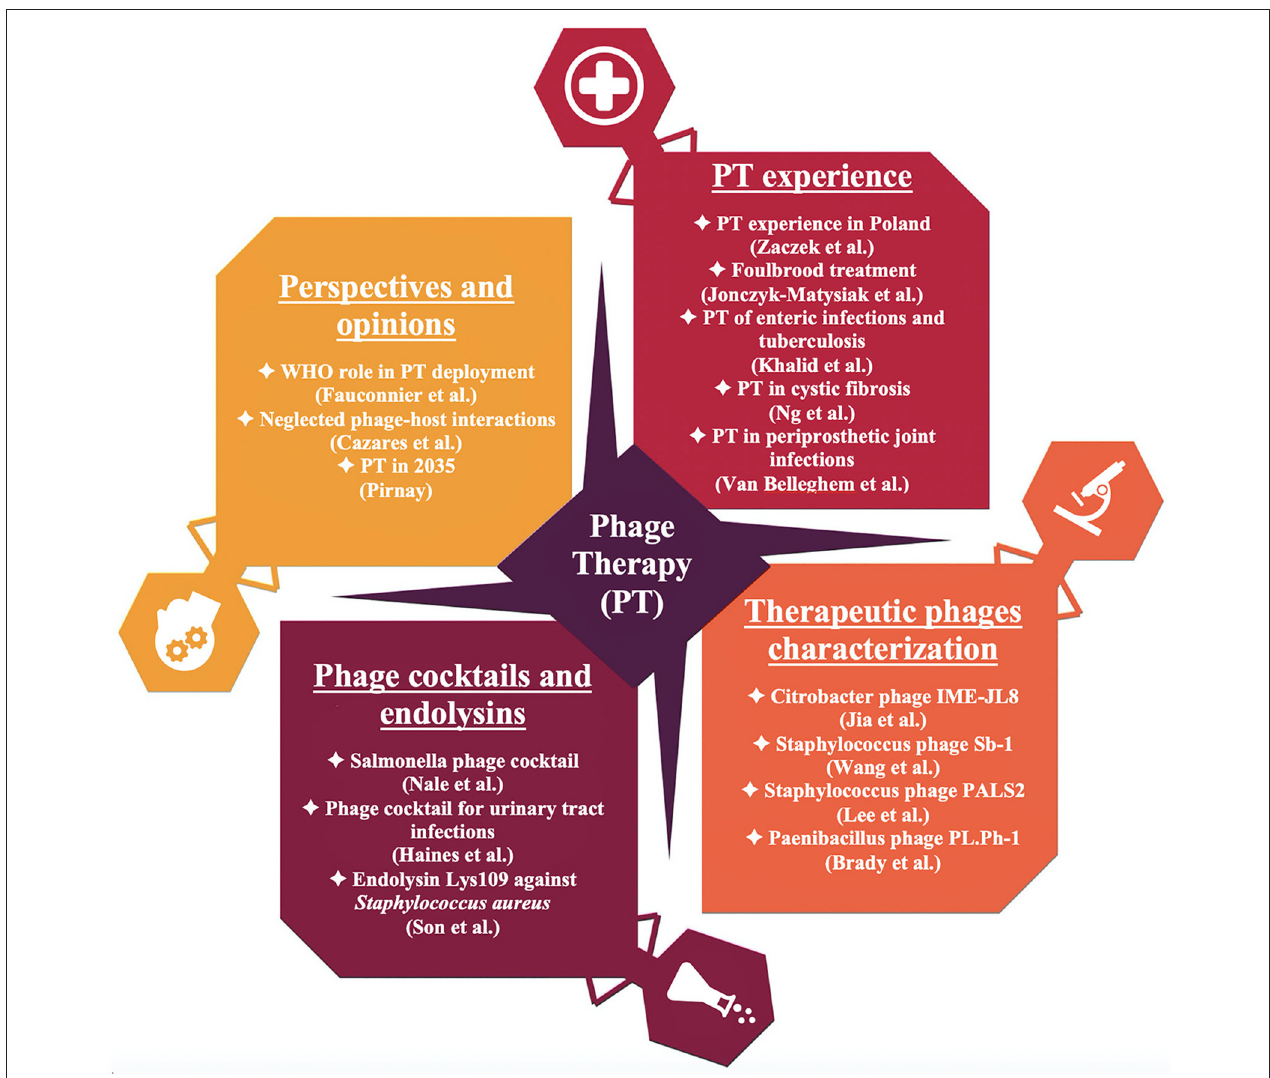
FIGURE 1 | Contribution of the issue Advances in Phage Therapy: Present Challenges and Future Perspectives to the state of